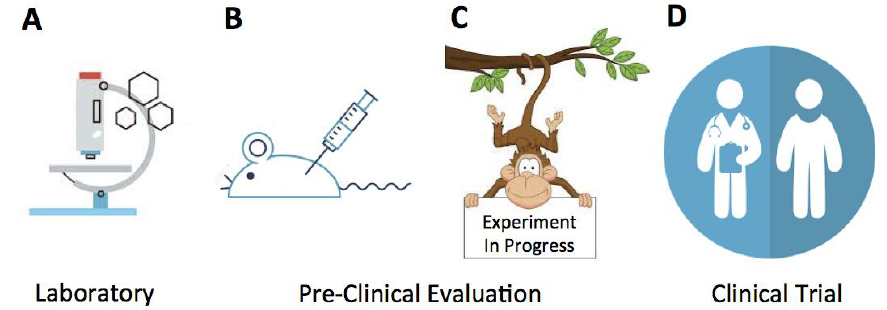
Figure 1. To maximize the potential of NHPs as pre-clinical models, it is essential to recognize function and information these models can generate in a cascade of events starting from: ( A ) the in vitro basic investigation; ( B ) concept validation; ( C ) pre-clinical trials; and ultimately ( D ) clinical studies.